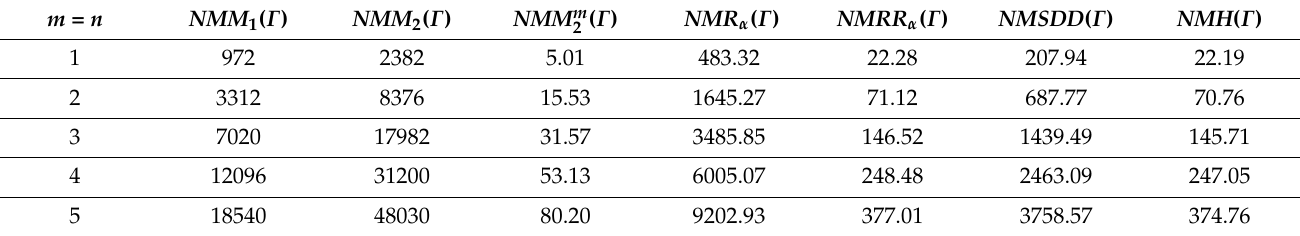
Table 13. Comparison Table for Theorem 8.